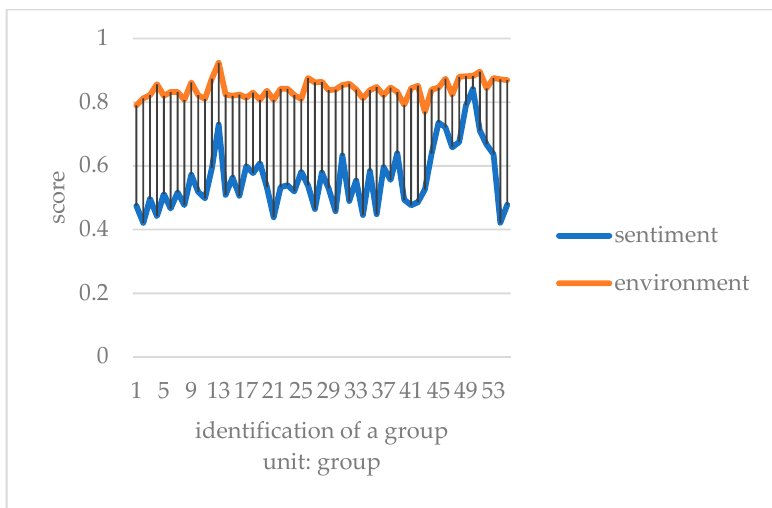
Figure 10. Chart of emotional score and dish taste after COVID-19.